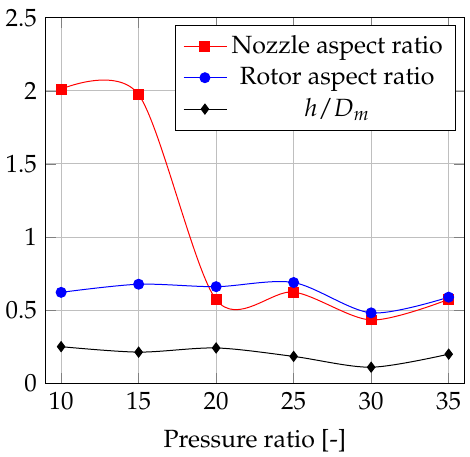
Figure 15. Turbine and flow parameters obtained for the optimal geometric configurations with optimized rotational speed. Pressure ratio versus nozzle and rotor aspect ratio and rotor outlet blade height to average